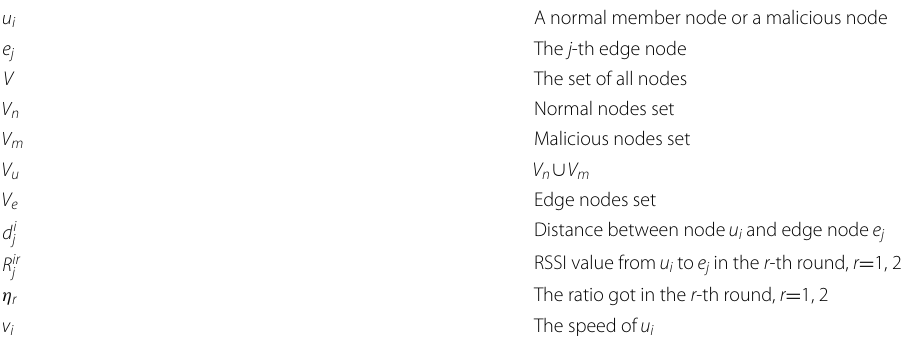
Table 1 Notations for problem